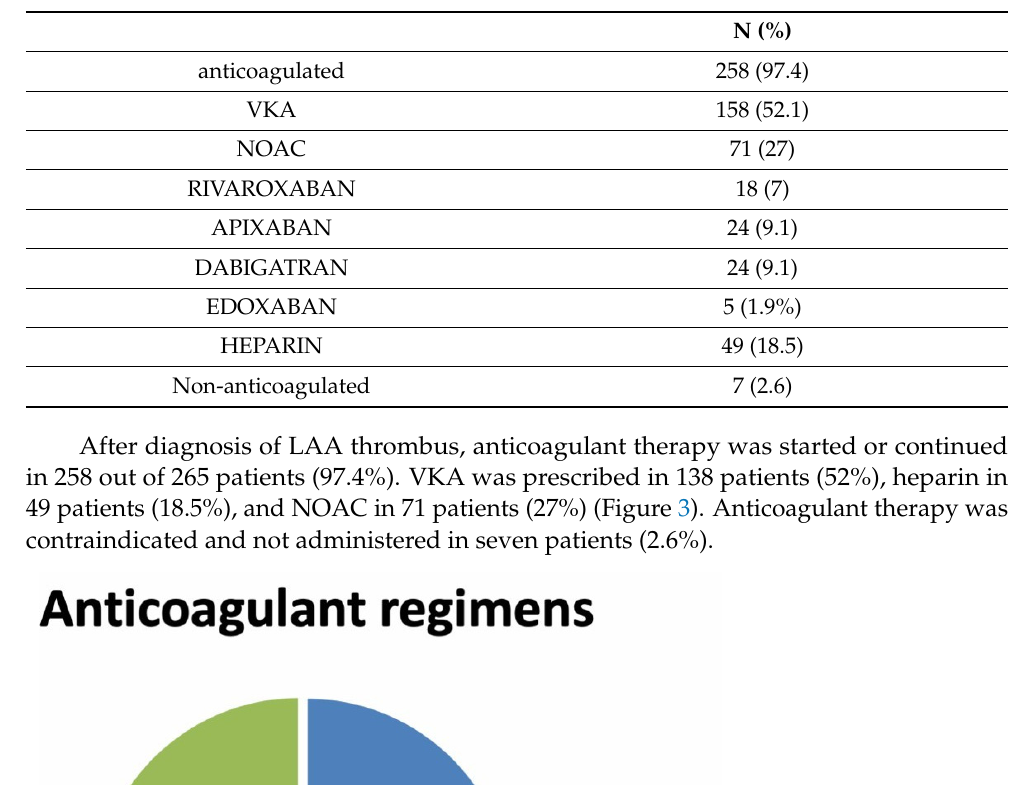
Table 3. Anticoagulant therapy after diagnosis of LAA thrombus. VKA, vitamin K s; NOAC, non- vitamin K antagonist oral anticoagulants.